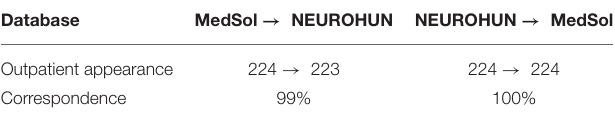
TABLE 2 | Number of outpatient record appearances in the hospital IT system (MedSol), the large national database (NEUROHUN) and